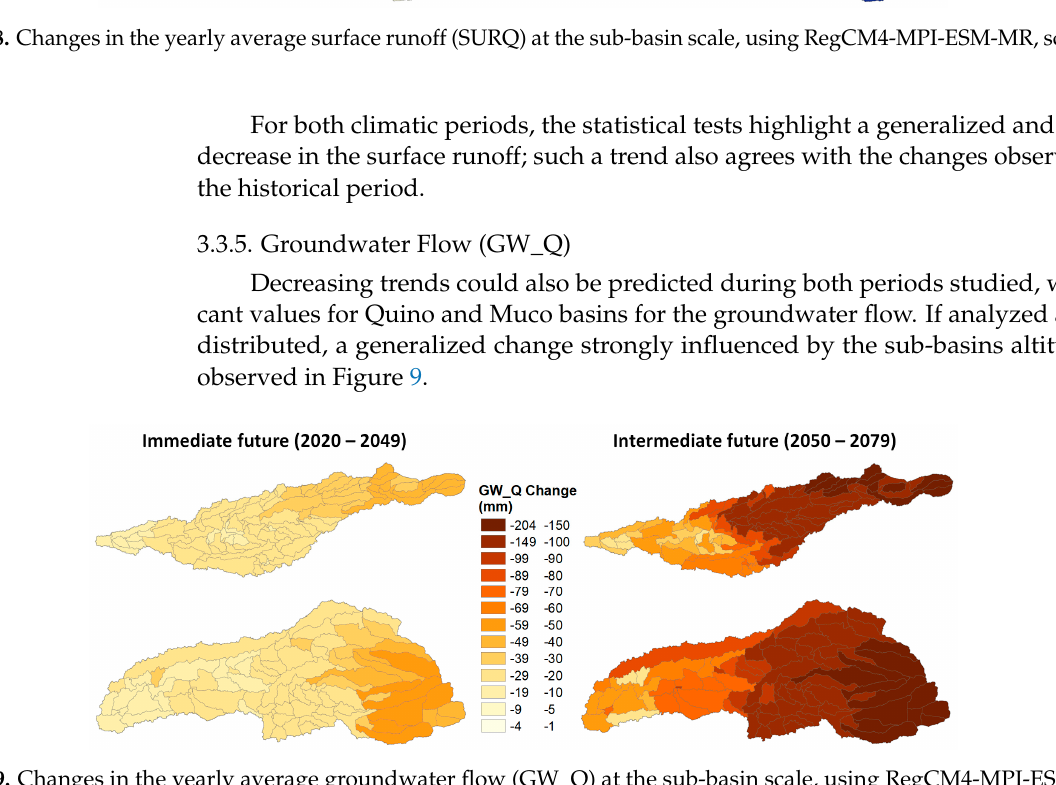
Figure 9. Changes in the yearly average groundwater flow (GW_Q) at the sub-basin scale, using RegCM4-MPI-ESM-MR, scenario RCP8.5.